Question: Express in one sentence what the figure is showing.
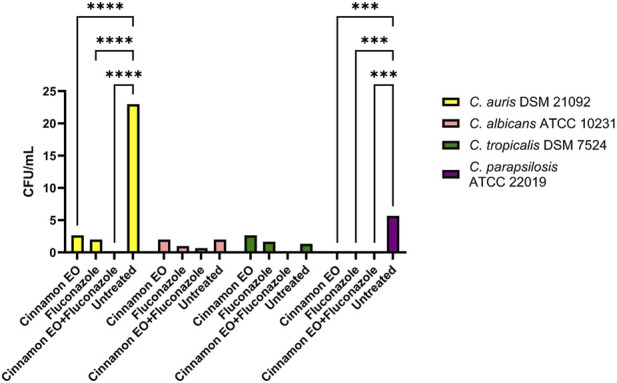
Answer: The number of CFU/mL recovered from G. mellonella homogenates following the administration of EO, fluconazole and their combination ( *** p < 0.001; **** p < 0.0001, ns- not statistically significant ).